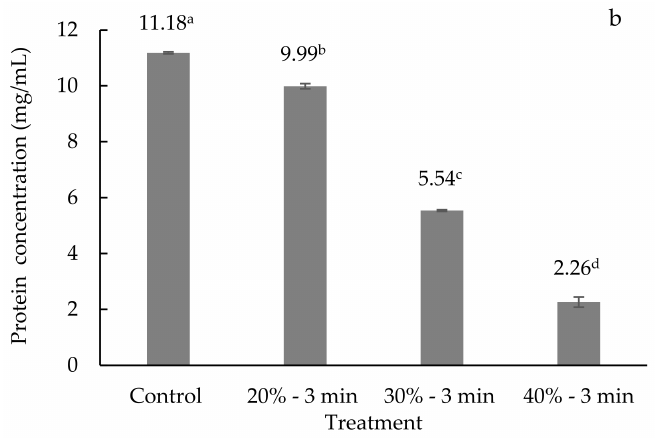
Figure 5. Effect of ultrasound (20 kHz) on the protein concentration of L. acidophilus ( a ) and L. helveticus ( b ). a,b,c,d Different literals in column indicate significant differences between treat- ments ( p < 0.05).